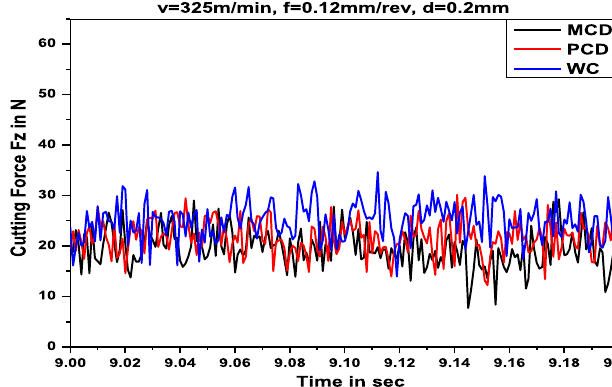
Fig. 12. Dynamic component of cutting force vs. time graph at v = 325m/min, f =0.12 mm/rev, d = 0.2mm.